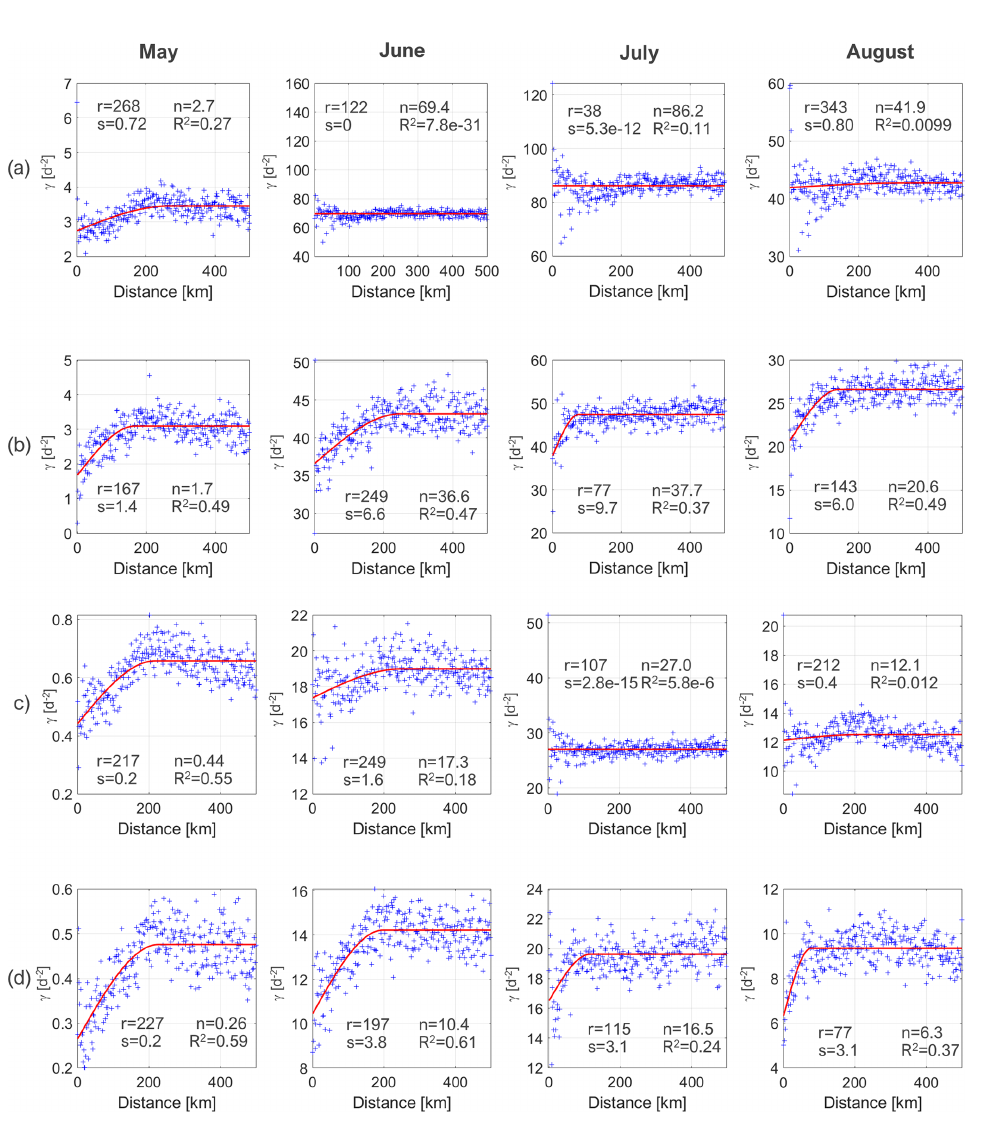
The Cryosphere, 15, 2623–2646,